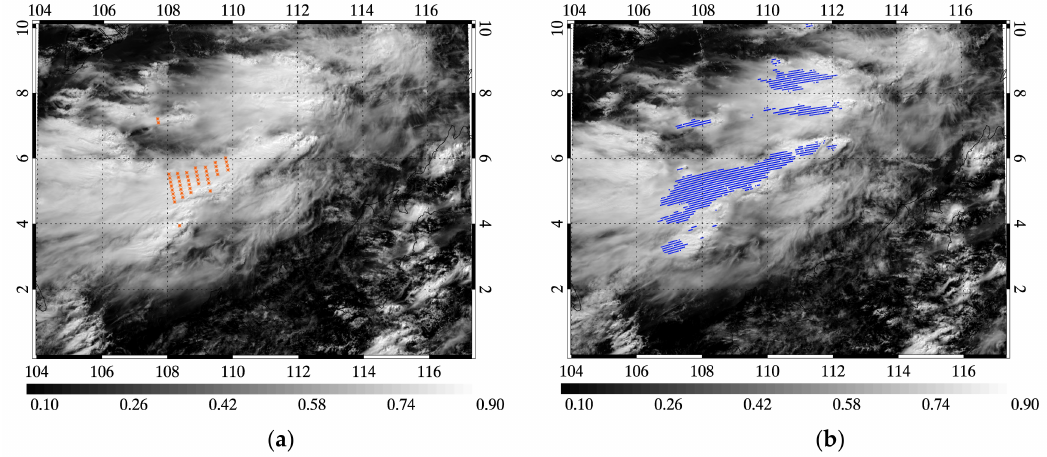
Figure 4. DCCs plotted on an AHI R 0.47 image: ( a ) OMI DCCs (orange dots) on 3 July 2018 06:10 UTC and ( b ) TROPOMI DCCs (blue dots) on 3 July 2018 06:40